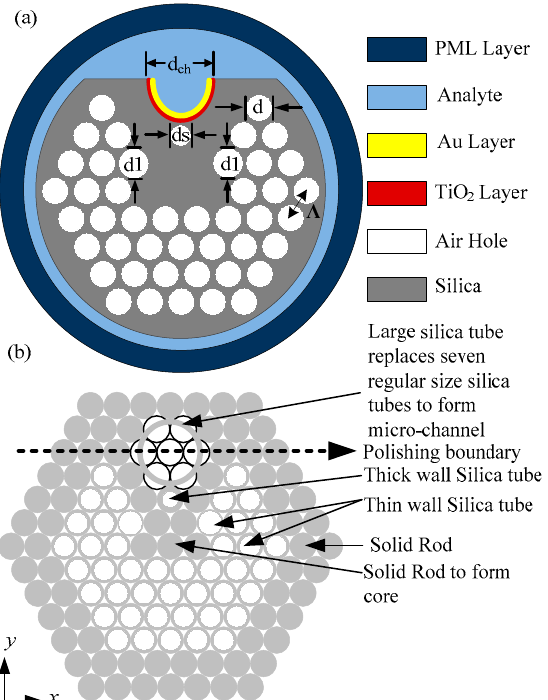
Figure 1. ( a )Schematic view of PCF -based SPR sensor, and ( b ) Fiber’s stack preform in the x–y plane.